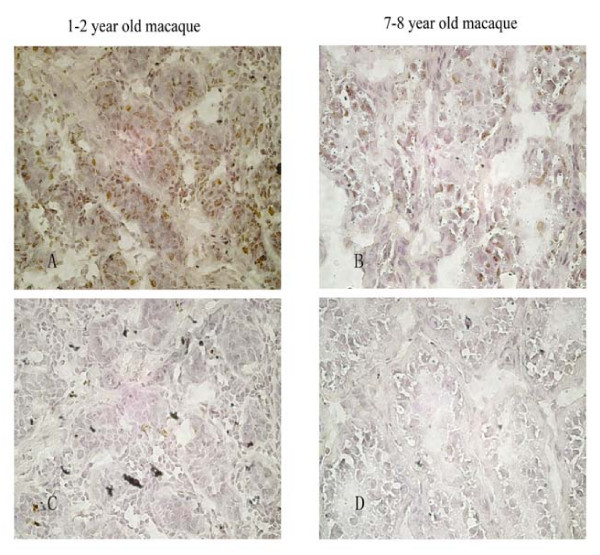
The in-situ immunohistochemical analysis of SCML1 during testis development. Both the 1–2 year old (A, C) and 7–8 year old macaques (B, D) were tested (40×). The expression of SCML1 is mostly located in spermatogonial stem cells (1–2 year old), and spermatogonia (7–8 year old). C and D are the controls without adding SCML1 mouse antibodies.